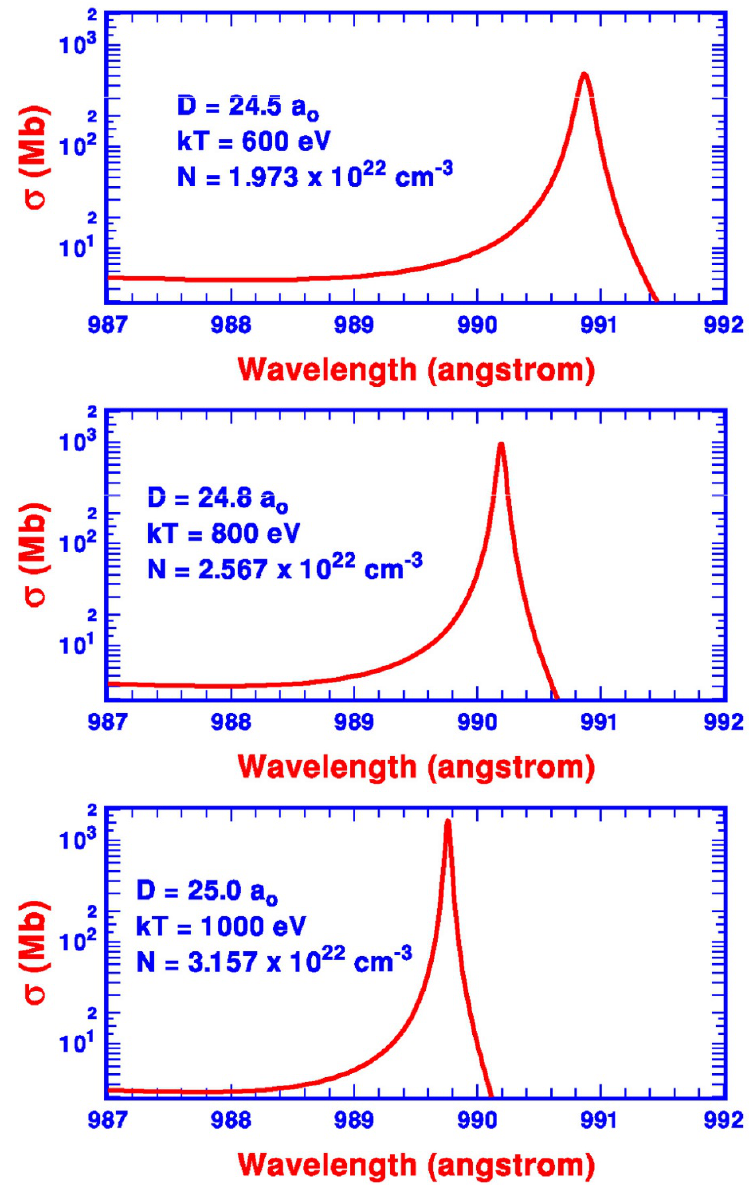
Figure 8. Hydrogen photoabsorption spectra from its ground state in terms of the cross-section σ (in units of Mb) corresponding to the 1 s → 4 p transition as D varies around 24.5 a o with A =